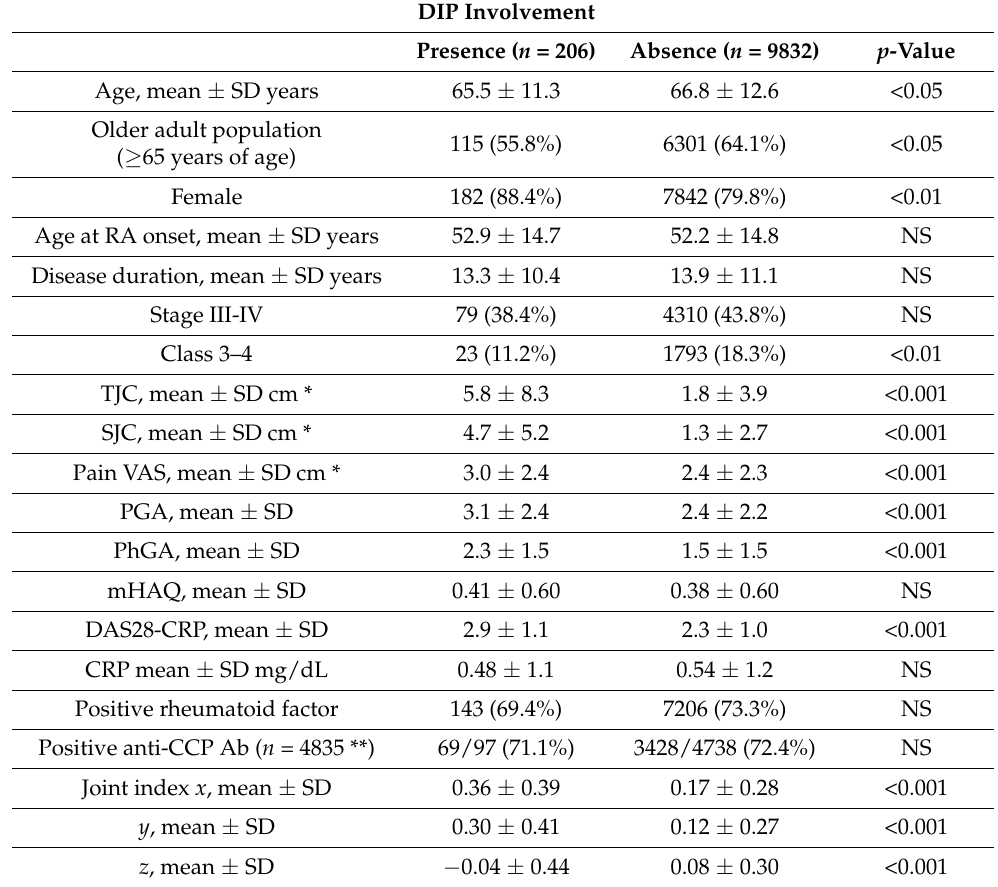
Table 1. Clinical characteristics of patients with rheumatoid arthritis (RA) in the presence or absence of distal interphalangeal (DIP) joint